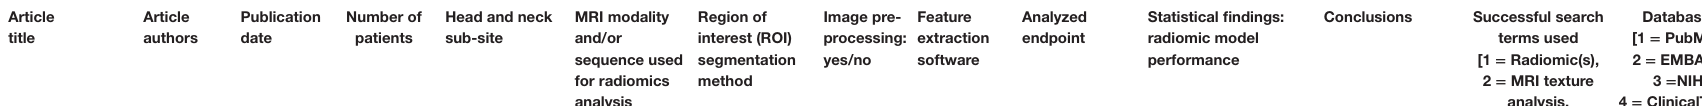
Texture analysis on parametric DCE-MRI maps revealed energy of ve was higher in intra-treatment vs. pre-treatment scans ( p <